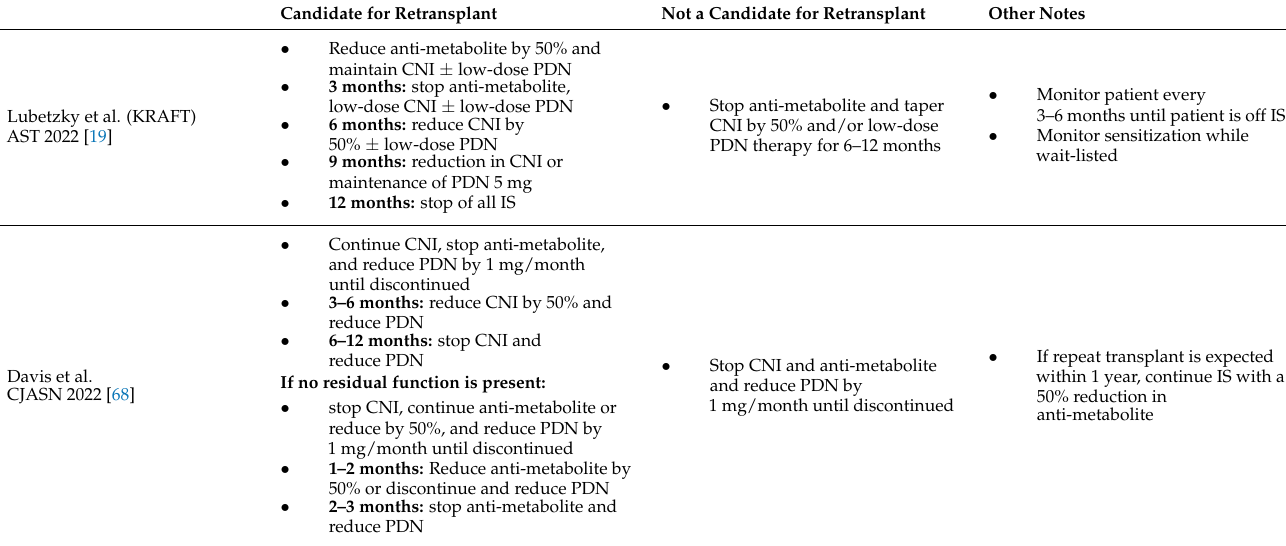
Table 1. Expert recommendations for immunosuppression withdrawal after kidney graft